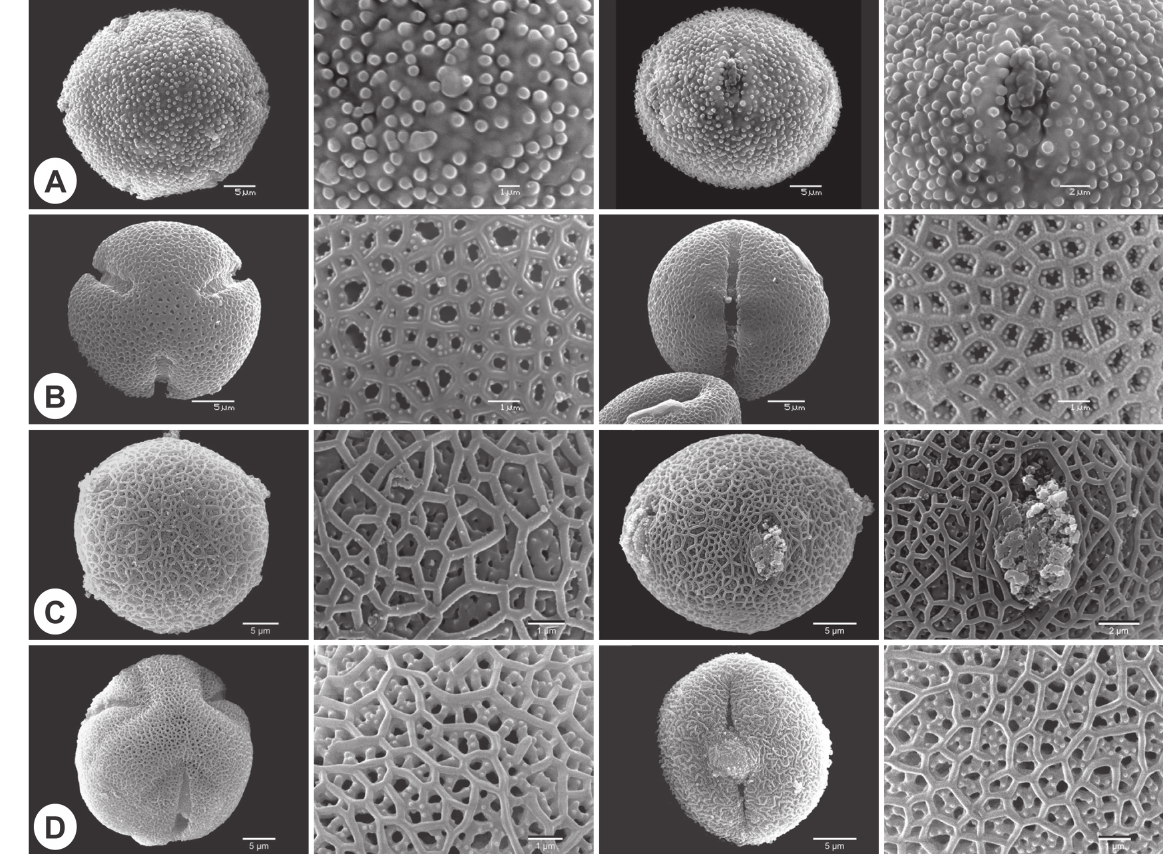
Fig. 4. Scanning electron microscopy micrographs of pollen in polar view (PV), the apocolpium (AC), pollen in equatorial view (EV) and the mesocolpium (ME). A . Astiella antsalovansis Groeninckx sp. nov. B . A. deblockiae Groeninckx sp. nov. C . A. delicatula Groeninckx sp. nov. D . A. desseinii Groeninckx sp. nov. Scale bars for A and C: PV, EV = 5 µm, AC = 1 µm, ME = 2 µm; for B and D: PV, EV = 5 µm, AC, ME =